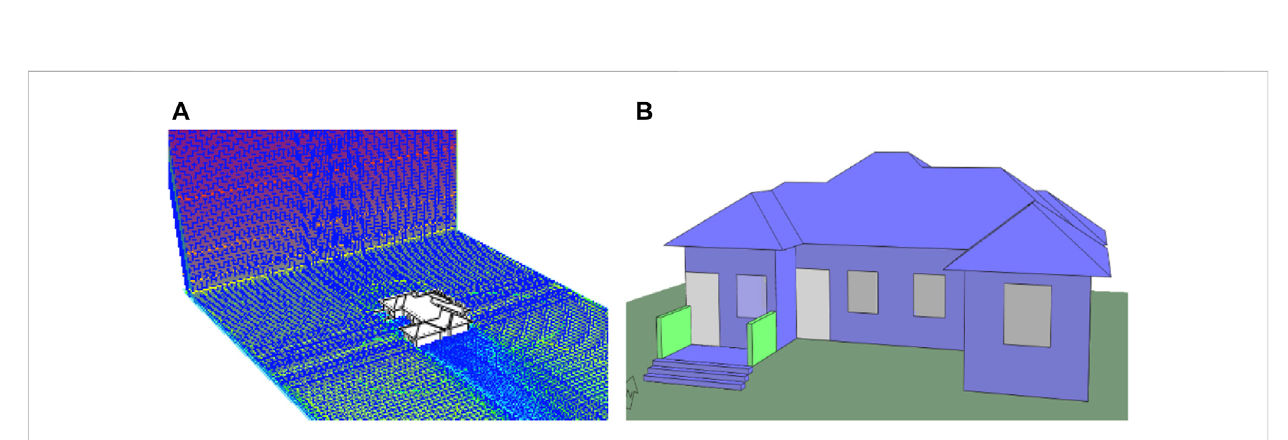
FIGURE 7 Wind analysis and related window size. (A) Wind analysis. (B) Size of windows matched to wind fl